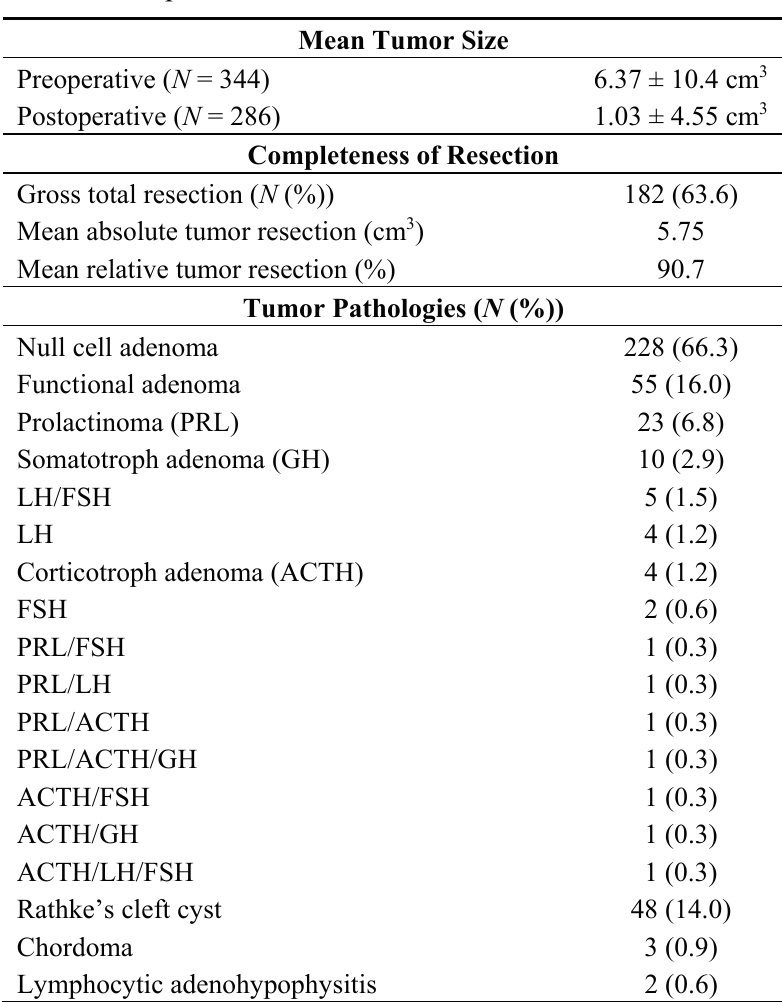
Table 2. Tumor size, resection success and anatomic pathology for 344 consecutive patients who underwent transsphenoidal resection of a pituitary mass at the authors’ institution between January, 2006, and December, 2012. PRL = prolactin; GH = growth hormone; LH = luteinizing hormone; FSH = follicle stimulating hormone; ACTH = adrenocorticotropic